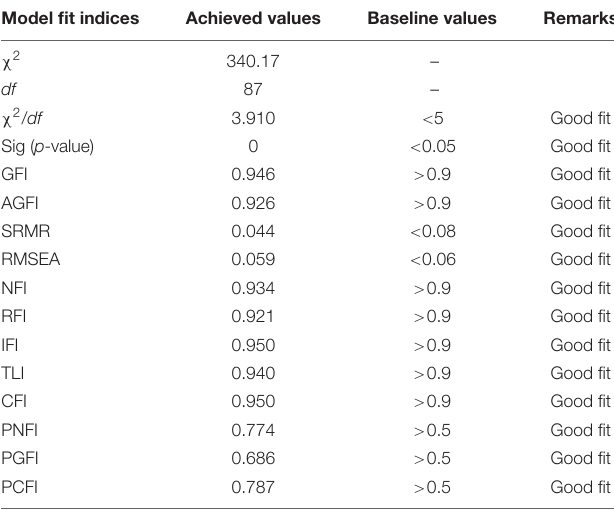
TABLE 4 | Confirmatory factor analysis (CFA) indices.